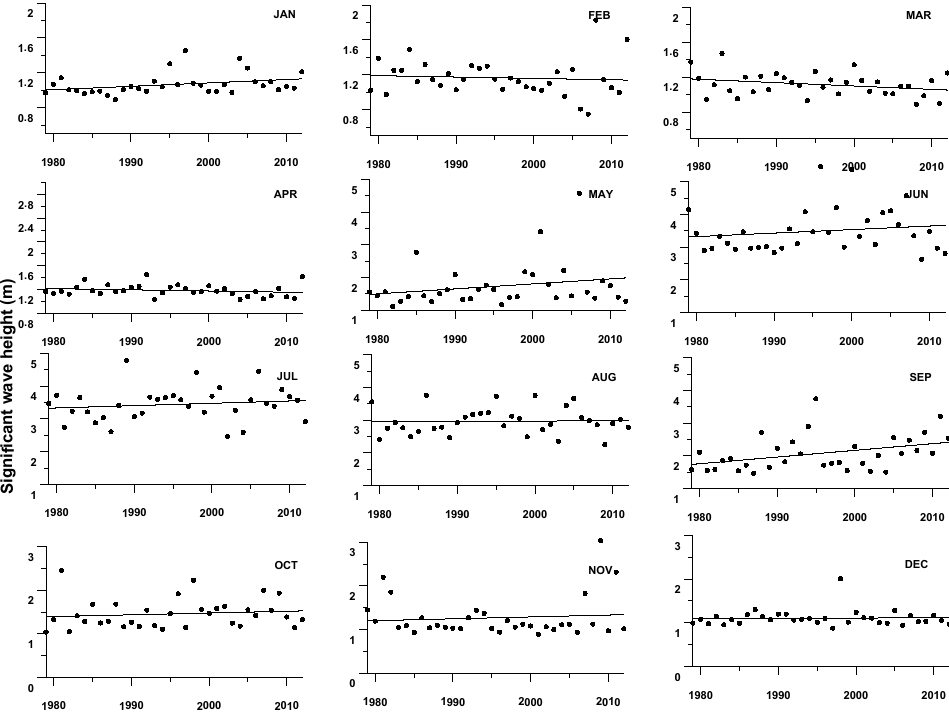
Figure 6. Temporal variation in monthly maximum significant wave height from 1979 to 2012.